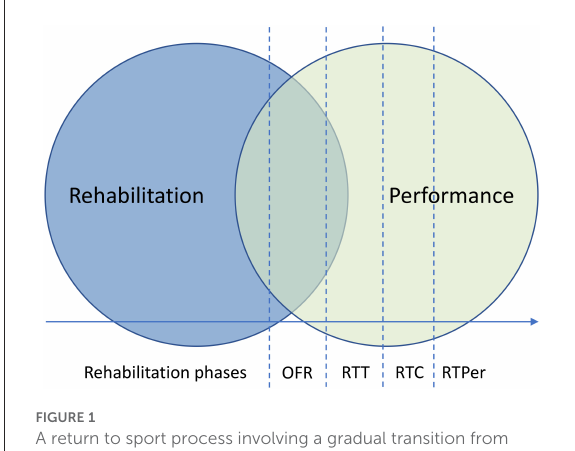
FIGURE1 A return to sport process involving a gradual transition from rehabilitation to performance training along a continuum of OFR, RTT, RTC, and RTPer. ORF, on-field rehabilitation; RTT, return to training; RTC, return to competition; RTPer, return to performance. Modified and re-printed with permission from Buckthorpe et al.